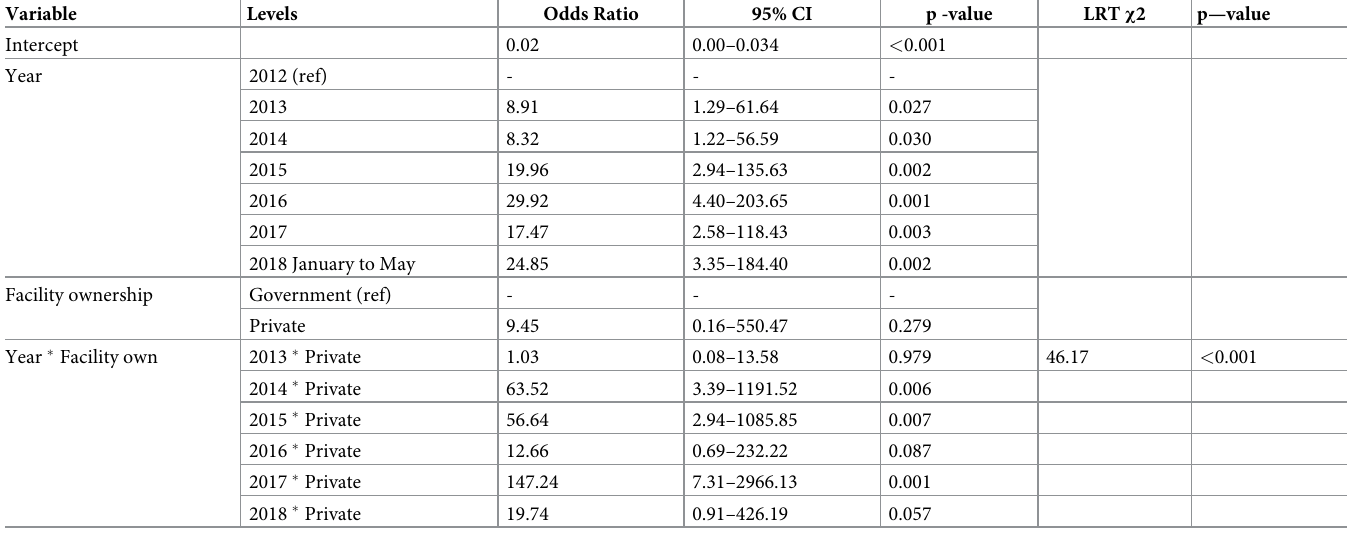
Table 2. Multivariable model of variables associated with brucellosis test performance by month at health facilities in Arusha region (n = 1300 monthly observa- tions from 23 facilities). Variable